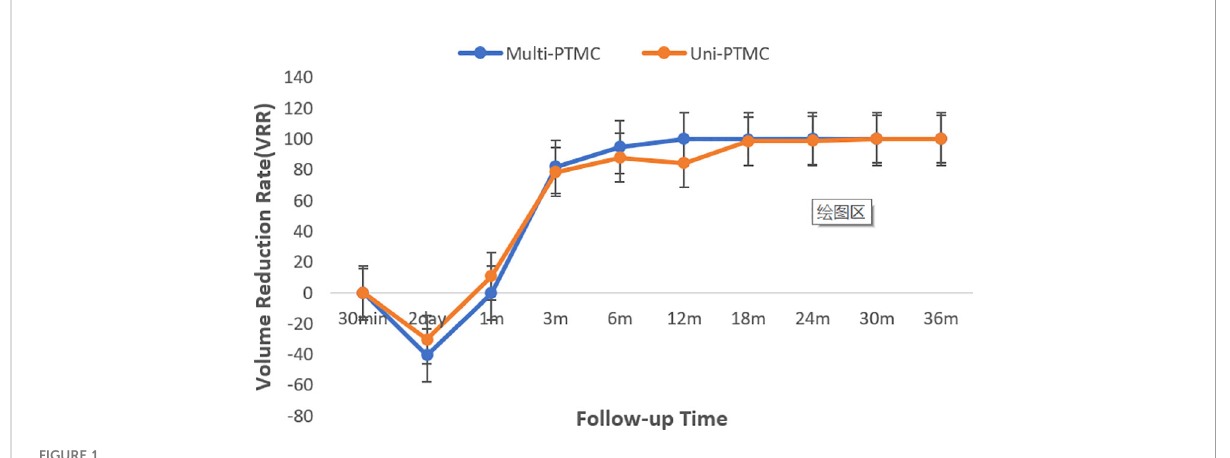
FIGURE 1 The diagram displayed the VRR at each follow-up after PLA.